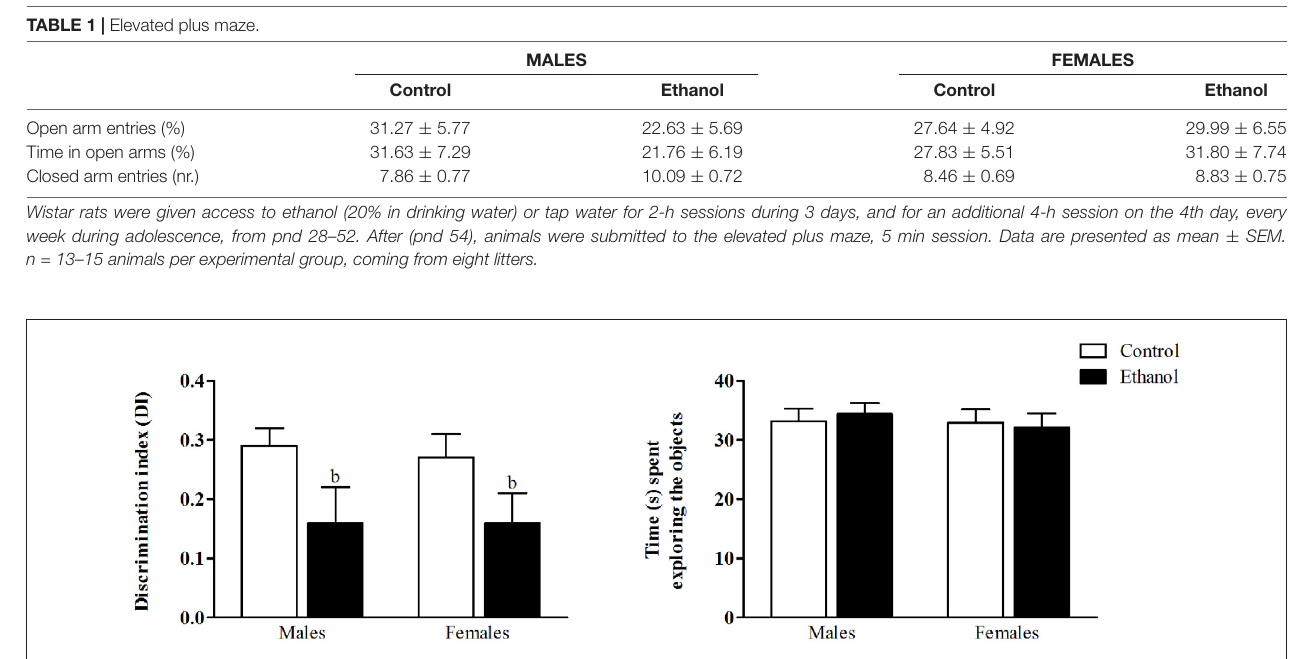
FIGURE 3 | Novel Object Recognition test (NOR). Wistar rats were given access to ethanol (20% in drinking water) or tap water for 2-h sessions during 3 days, and for an additional 4-h session on the 4th day, every week during adolescence, from pnd 28–52. At adulthood (pnd 63), animals were submitted to the NOR test. The discrimination index (DI) was calculated as the difference between the time spent exploring the novel object (N) and the familiar one (F1 or F2) in relation to the total time spent exploring the objects ((N − F)/(N + F)). Data are presented as mean ± SEM. Analysis of variance (ANOVA), b p < 0.05, general effect of treatment. n = 13–15 animals per experimental group, coming from eight